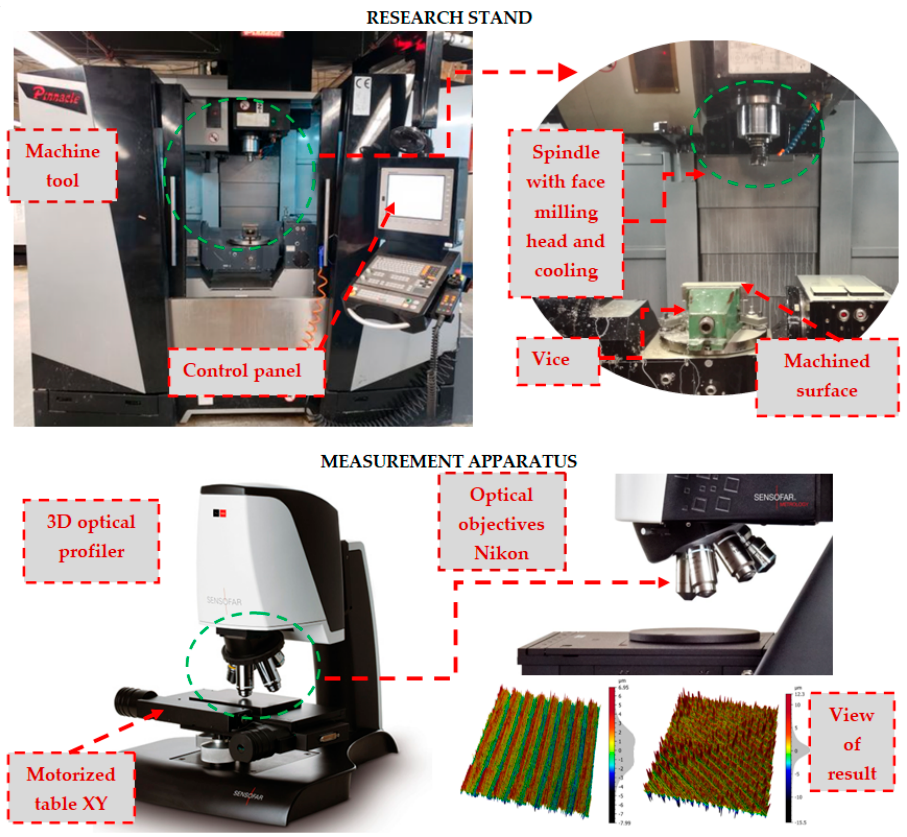
degrees Table 3. Kinematic parameters of the face milling process.